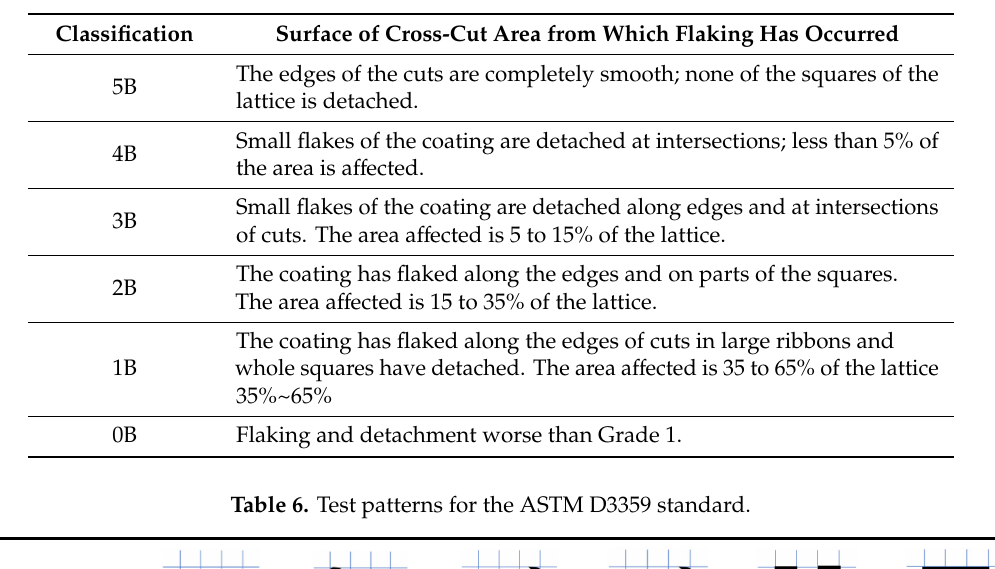
Table 5. ASTM D3359 standard.